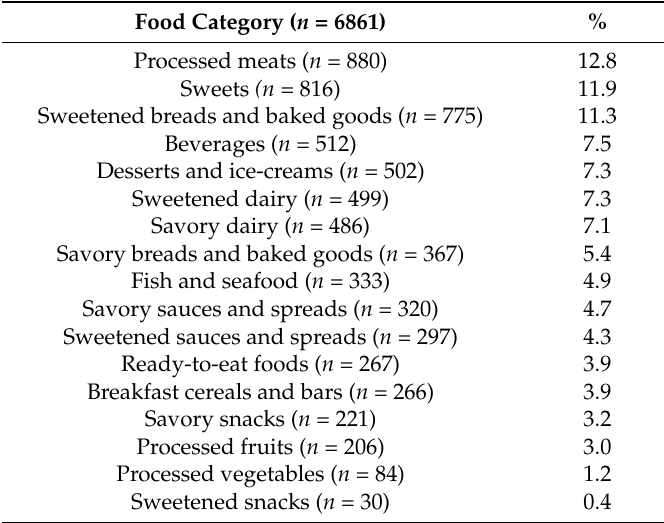
Table 2. Study sample by food category in rank order of